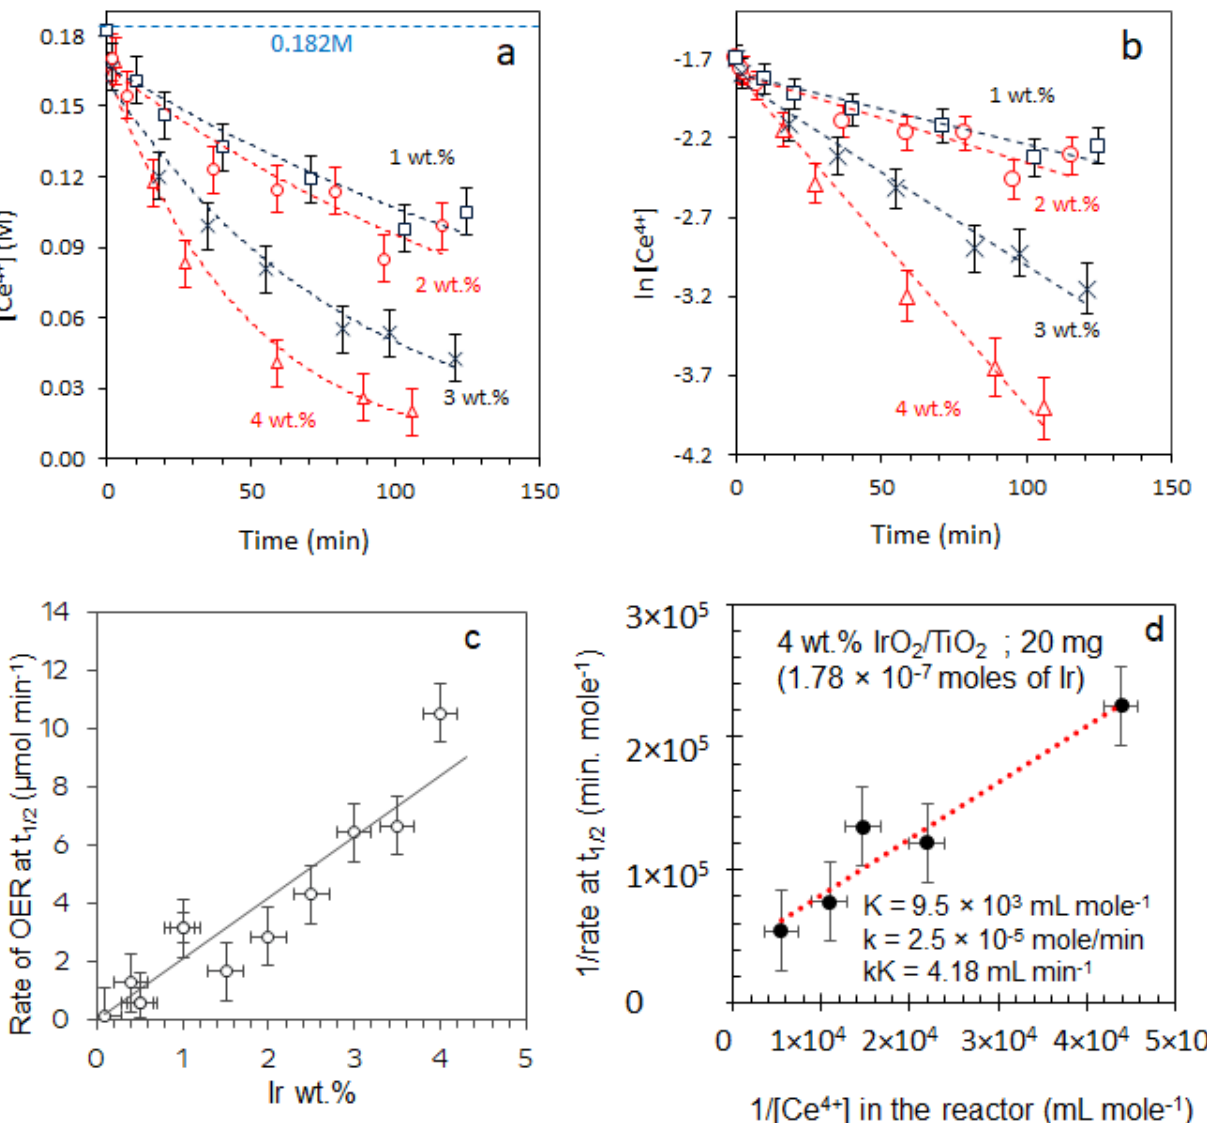
Figure 10. ( a ) Change of Ce 4+ cation concentrations with reaction time using different IrO 2 /TiO 2 (anatase) catalysts with Ir wt.% values from 1 to 4. ( b ) Logarithm of the Y-axis in ( a ). ( c ) Reaction rates at t 1/2 as a function of Ir content of the different catalysts studied. ( d ) L-H plot of the data in Figure 10c. The two parallel red lines in ( c ) are for the confidence integral based on the results. All data were collected at the same condition with 0.182 M of initial Ce 4+ concentration.